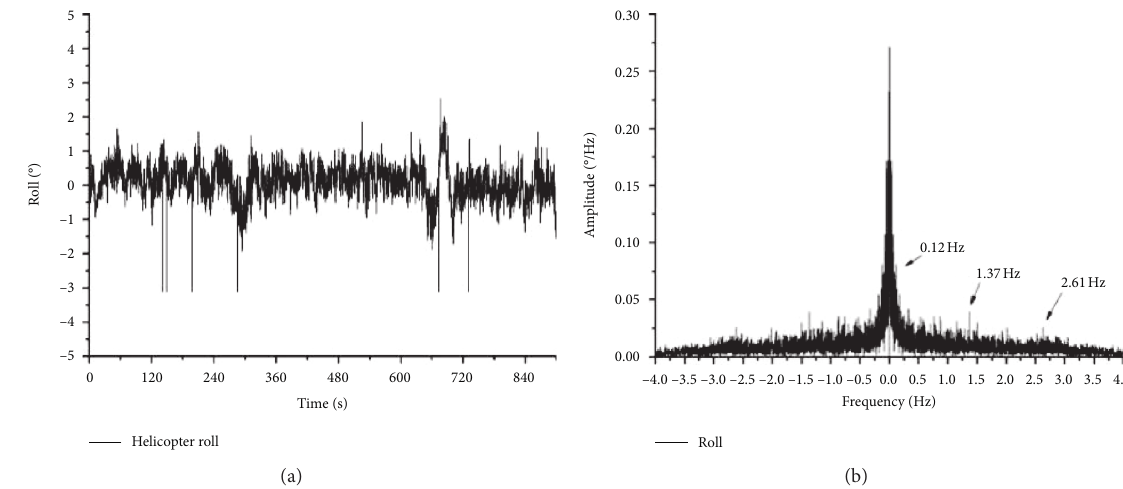
Figure 17: (a) Roll angle change of helicopter hovering. (b) Rollover spectrum change of helicopter